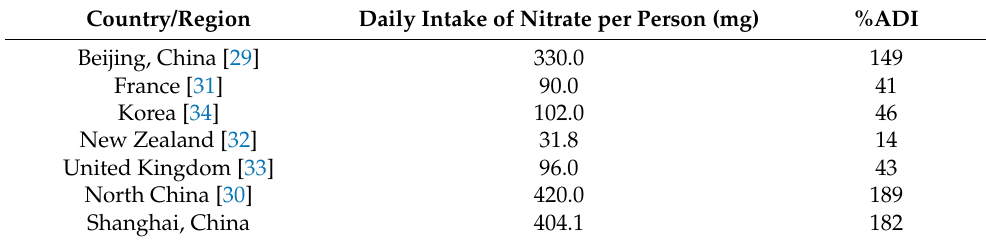
Table 6. International comparison of average daily exposure to nitrate.